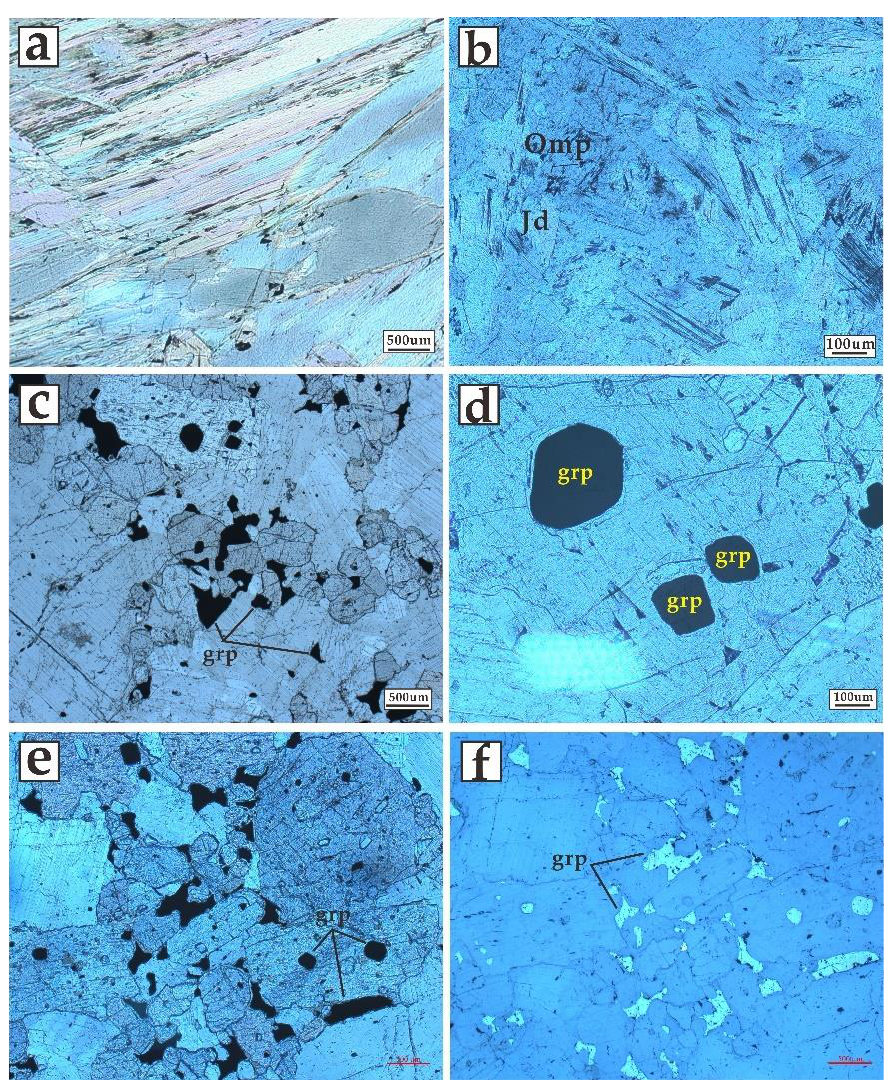
Figure 7. Micrograph of ( a ) orientation arrangement of katophorite and mica; ( b ) omphacite schlieren fills in the cleavage of jadeite; ( c , d ) amorphous and euhedral graphite of Sample 3; ( e ) dispergated graphite of Sample 4; ( f ) graphite with metal luster under reflected light.